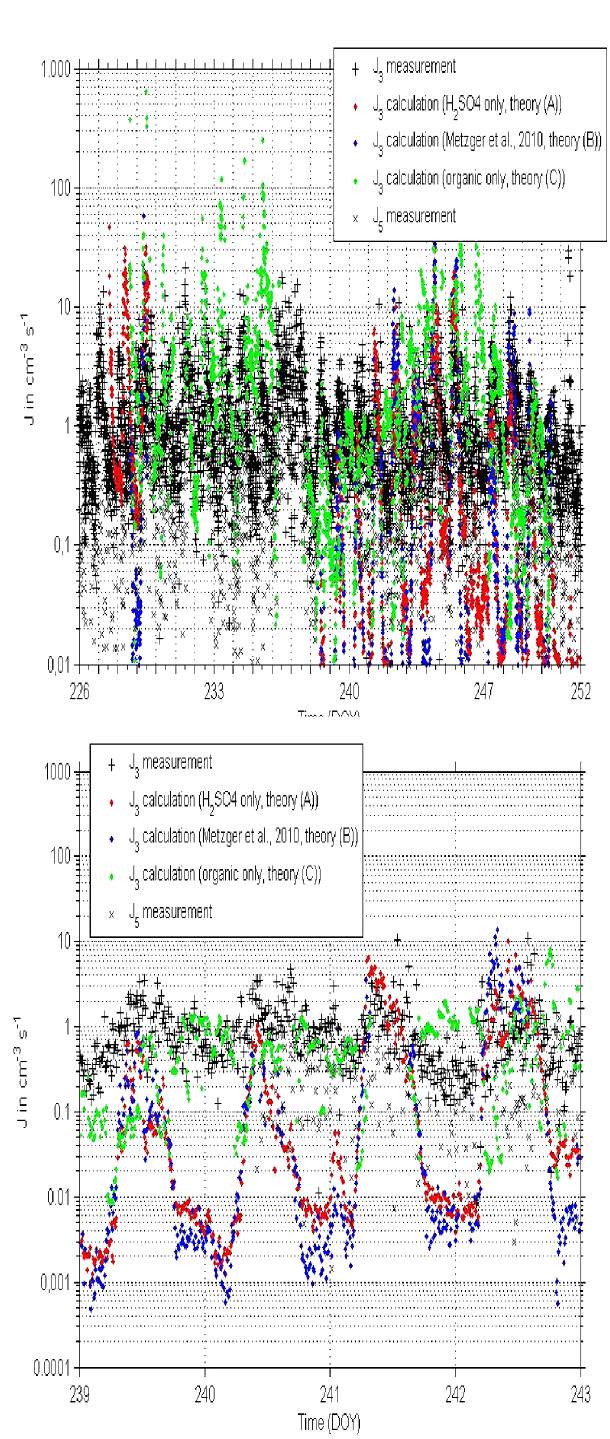
Figure 10. Top: measured and derived particle formation rates at 3nm in particle diameter; bottom: at 5nm. The focus on five days only is in order to show the behaviour at different times of the day.